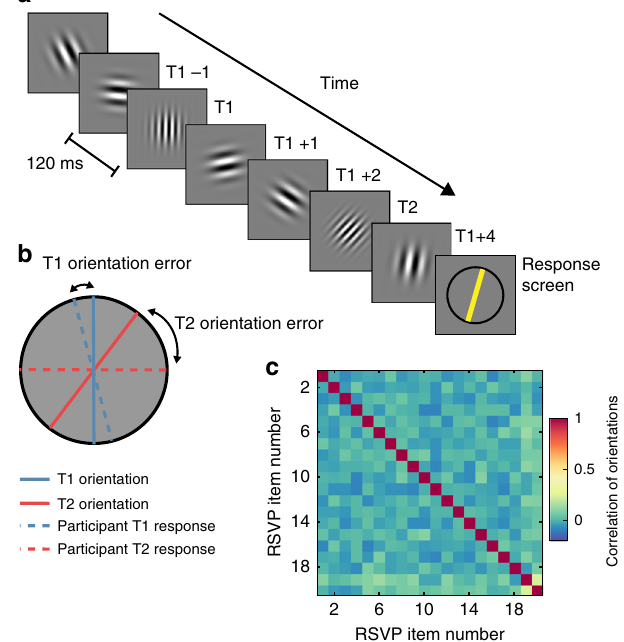
Fig. 1 Schematic of stimuli and timing of displays in the rapid serial visual presentation (RSVP) task. a An illustration of a typical trial in the RSVP task, which consisted of 20 sequentially presented Gabor patches at fi xation. Each of the twenty items within a single RSVP stream was presented for 40 ms, with an 80 ms blank interval between items (120 ms inter-stimulus interval), yielding an 8.33 Hz presentation rate. The number of items (Lag) between the fi rst (T1) and second (T2) targets was varied to measure the temporal duration of the AB. At the end of each RSVP stream, participants reproduced the orientations of T1 and T2 (higher spatial- frequency gratings) in the order in which they were presented by adjusting an on-screen cursor at the end of the trial. They were asked to determine the orientations as accurately as possible and were not given any time restriction to do this. Visual feedback was provided following the response. b A schematic of the feedback screen for responses. c The correlation values between orientations of the RSVP items over trials in Experiment 1. As Gabor orientations were randomly drawn (without replacement) on each trial, across all trials the orientation of any given item in the stream was uncorrelated with the orientation of any other item. This permitted the use of regression-based approaches to isolate the behavioural and neural processing of individual items independently of surrounding items within the stream. The correlations were calculated for each participant and are displayed as averaged across